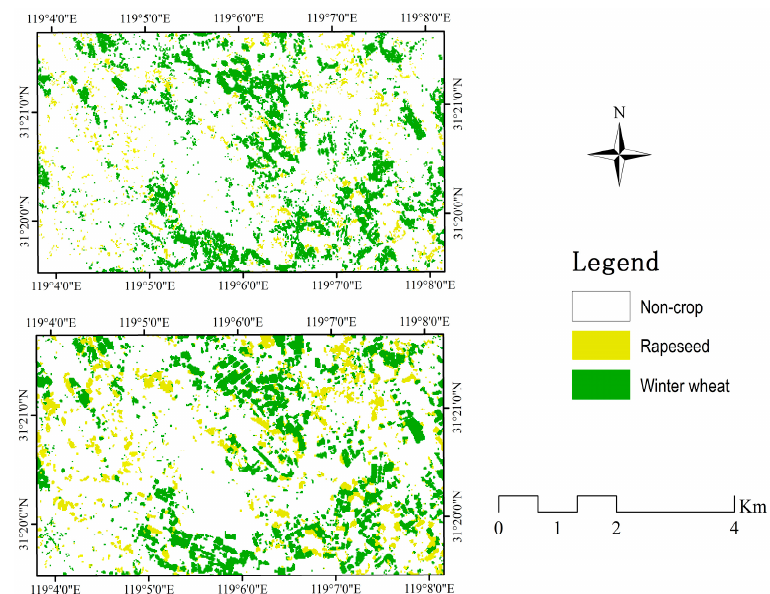
Figure 7. Incremental classification accuracy of winter wheat with backscatter intensity, coherence, and texture images by adding every new image acquisition to all previously available images.